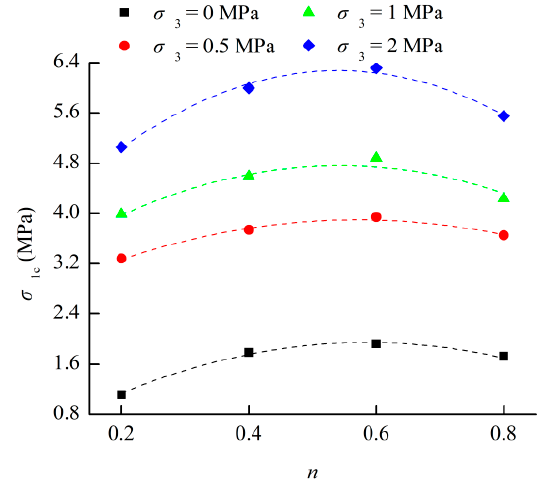
Figure 4. Relationship between the elastic parameters (Poisson ratio and elastic modulus) and Talbot index.